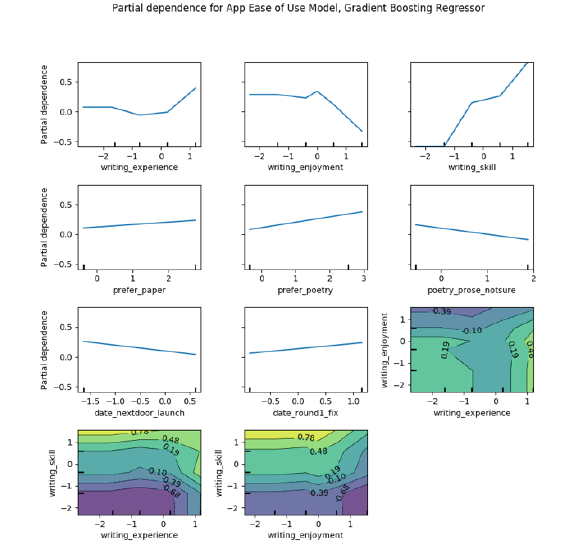
Figure 28. Partial dependence for Question 6 model